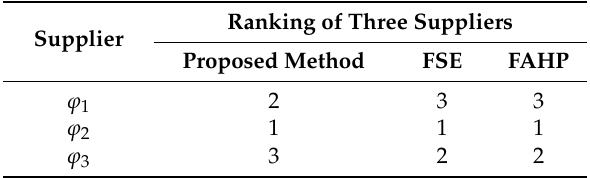
Table 4. The comparison of assessing results of the proposed method, FSE and FAHP. Ranking of Three Supplier